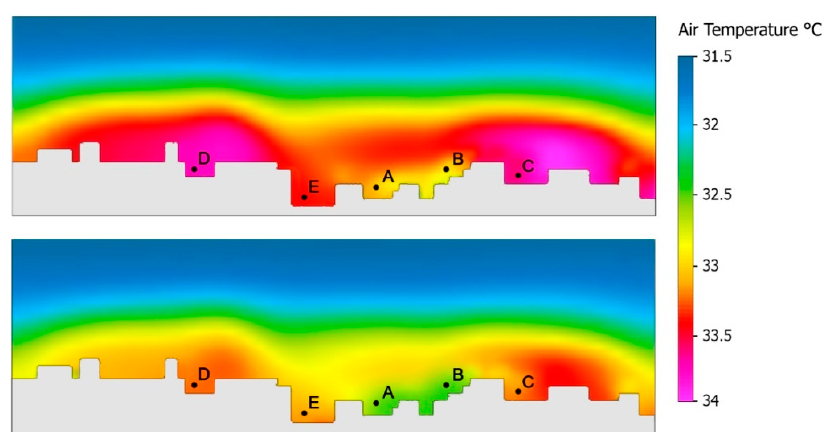
Energies 2017 , 10 , 351